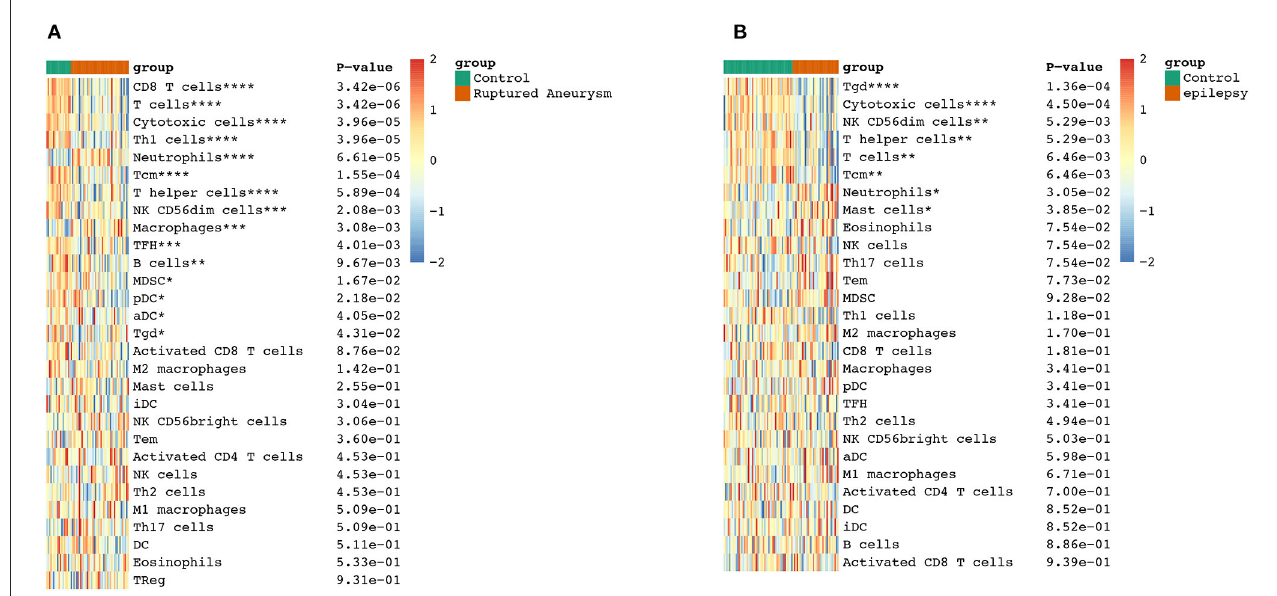
FIGURE6 Extraction of immune-related DEGs in SAH (A) and epilepsy (B) . Green and red represent the control and experimental groups, respectively. DEGs, differentially expressed genes; SAH, subarachnoid hemorrhage. * P < 0.05; ** P < 0.01; *** P < 0.005; **** P < 0.001.